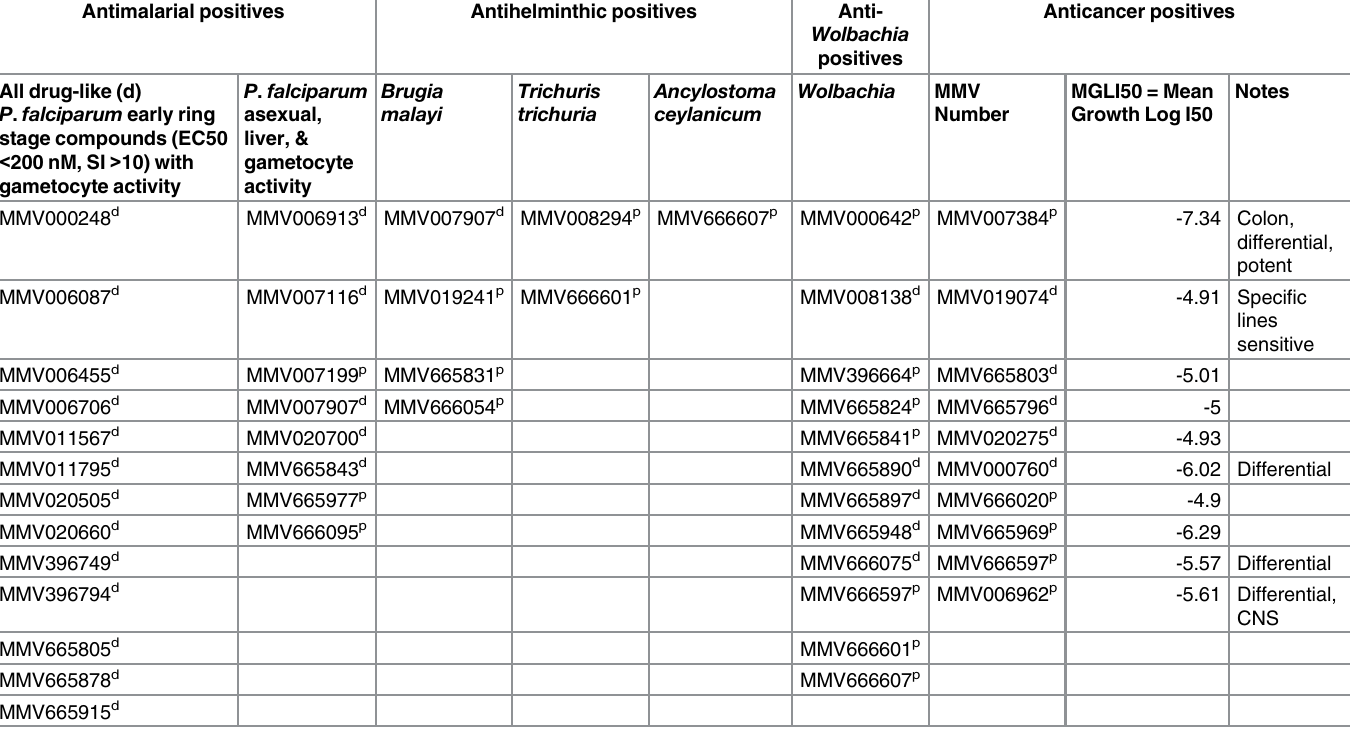
Table 1. Malaria Box compounds with activity in biological assays (malaria, helminths, Wolbachia , and cancer cells) and lacking toxicity at thera- peutic levels. Selectivity Index, SI, is toxicity level/activity level; p, probe-like; d, drug-like. Antimalarial positives